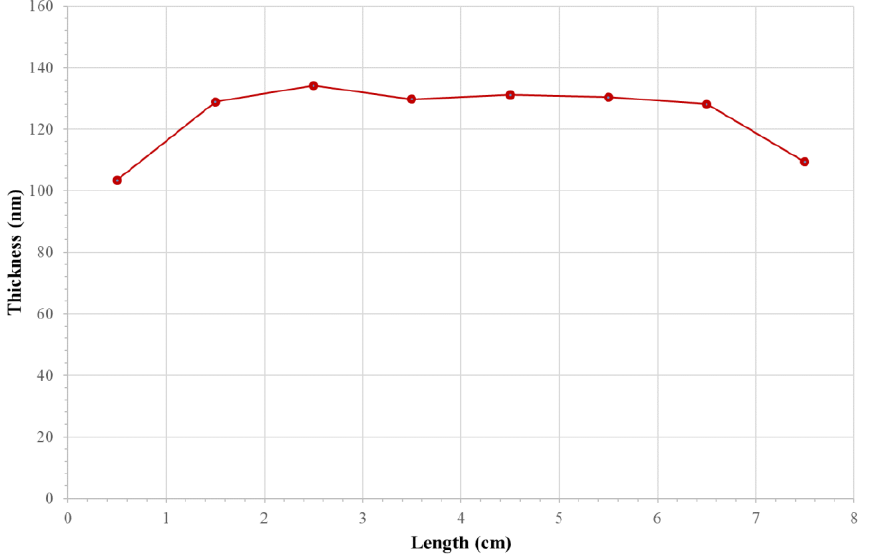
Figure 8. ATR – FTIR spectrum for PP-MMA coating inside the silicone tube corresponds to the 100 W (RF) plasma and 40 volume percentage of monomer. ( a ) The whole ATR-FTIR spectrum for PP-MMA-coated/-uncoated silicone tubes. ( b ) Band depiction of PP-MMA on the inner surface of the silicone tube in the range of 1460 to 1480 cm − 1 . ( c ) Band depiction of PP-MMA on the inner surface of the silicone tube in the range of 1800 to 1810 cm − 1 . The uncoated tube represents the condition in which there was no plasma initiation inside the tube.